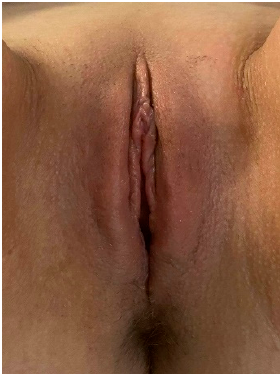
Figure 4. The aesthetic improvement in vulva or lack of it on the Global Aesthetic Improvement Scale (GAIS).